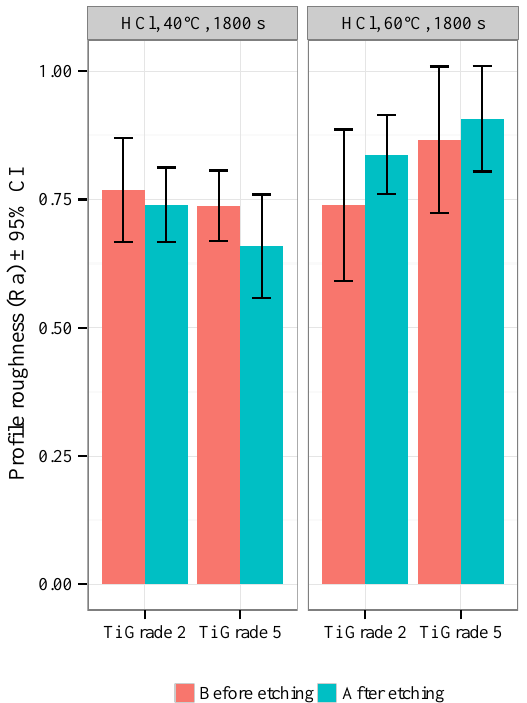
Figure 2. Mean profile roughness values and their 95% CIs for Ti grade 2 and Ti grade 5 discs before and after etching in 30% HCl at 40°C for 1800 seconds and at 60°C for the same